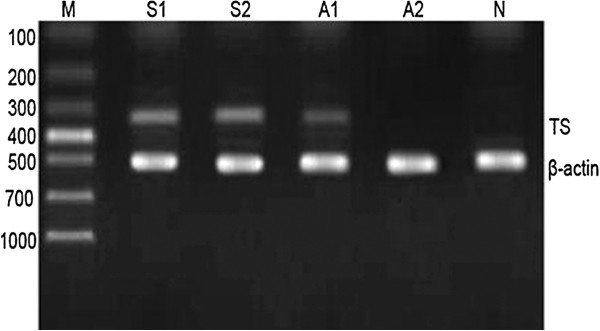
Elevated expression of TS mRNA in NSCLC tissue specimens compared to normal tissues. Surgical specimens were taken from patients with lung adenocarcinoma (A) or squamous cell carcinoma (S) and the corresponding normal mucosae (N) and subjected to semi-quantitative RT-PCR analysis of TS expression. The data are summarized as mean ± standard deviation relative to β-actin. The size of TS and β-actin PCR products was 337 bp and 500 bp, respectively. S (0.712 ± 0.183) compared with A (0.712 ± 0.183), P < 0.05.